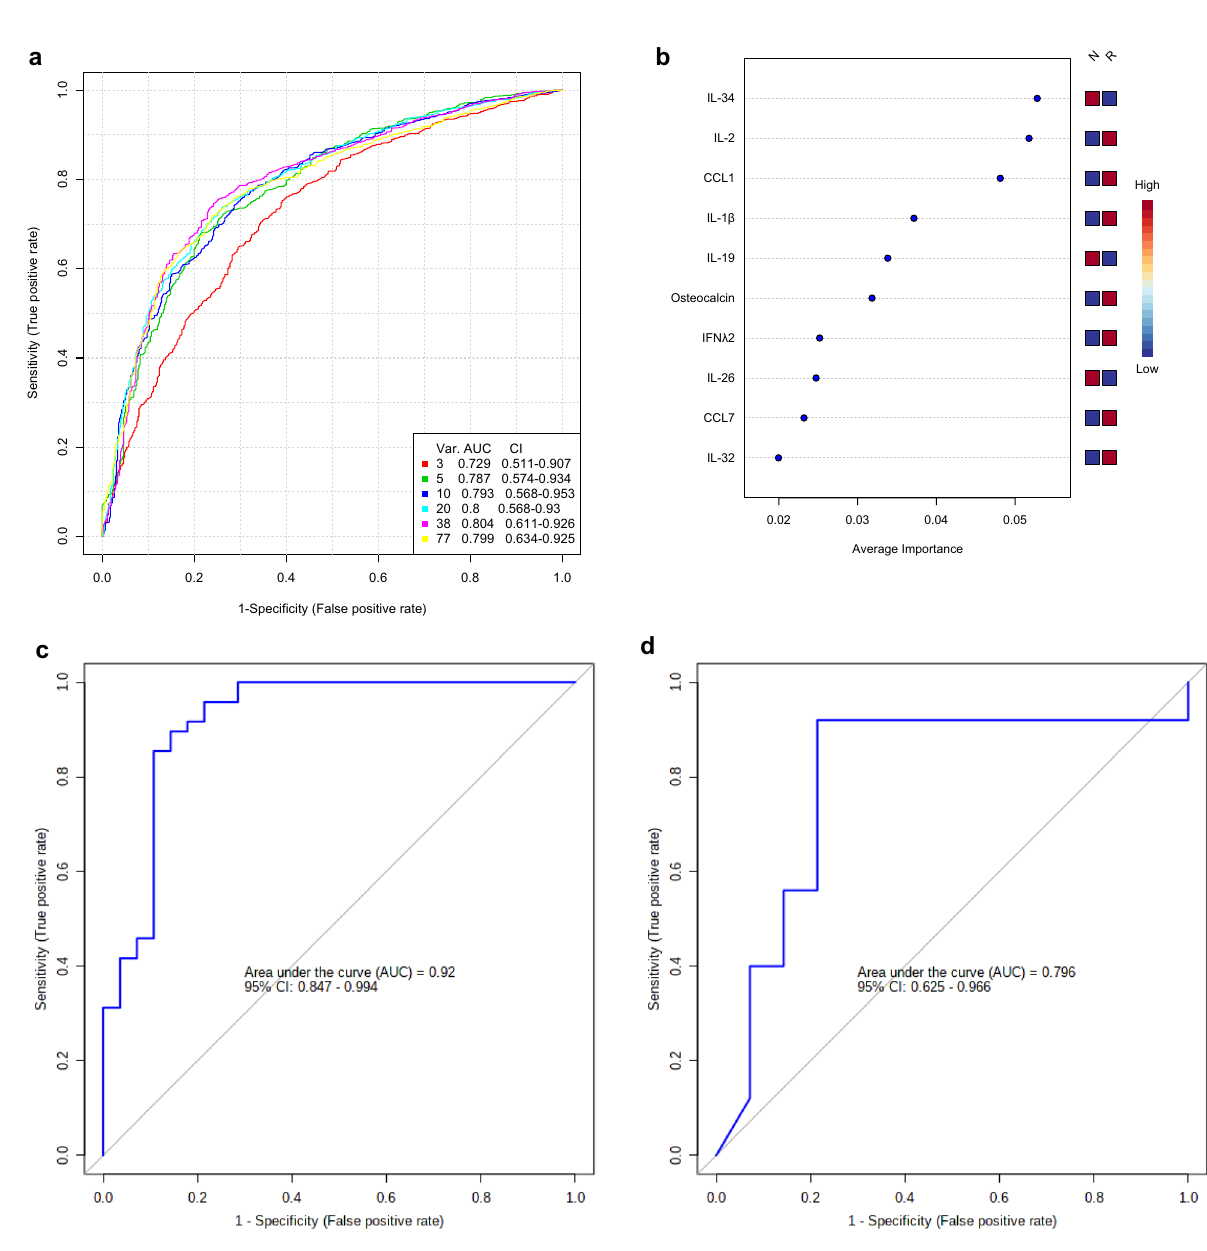
Figure 7. Selection of the significant five biomarkers. ( a ) Comparison of six ROC curve models created using linear support vector machine (SVM) algorithm with different numbers of features (3, 5, 10, 20, 38 and 77). The legend shows the AUCs and confidence intervals (CI) of the six models. ( b ) Top 10 significant biomarkers ranked based on mean importance measure in descending order of importance. ( c ) ROC curve plot from five biomarker combination created using logistic regression algorithm with tenfold cross-validation. The ROC curve was generated using a combination of IL-34, IL-2, CCL1, IL-1β, and IL-19, which are selected as top five significant biomarkers in ( b ). The serum concentration of the analyte was measured in each patient at time points A and F in the sustained remission group and at time points B and C in the relapse group (Fig. 1). ( d ) ROC curve evaluation of the five-biomarker model using serum from the relapsed and non-relapsed patients at bDMARDs-withdrawal. The ROC curve was generated as described in ( c ). The serum concentration of the analyte was measured in each patient at time point A in the sustained remission group and at time point B in the relapse group (Fig. 1). The images were created using MetaboAnalyst (ver. 4.0, https:// www. metab oanal yst.